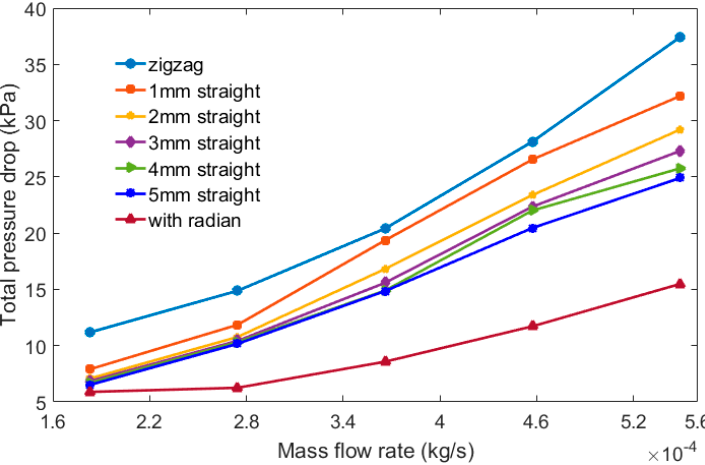
Figure 12. Total pressure drops for different channel shapes at different mass flow rates. Energies 2019 , 12 , x FOR PEER REVIEW